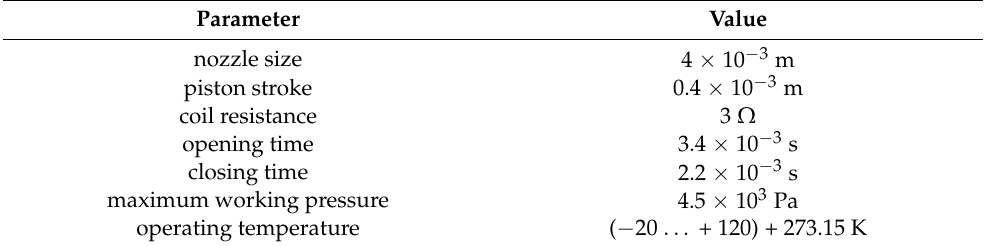
Table 1. The technical data of the Valtek Rail Type-30 injector. Data taken from Ref. [68].